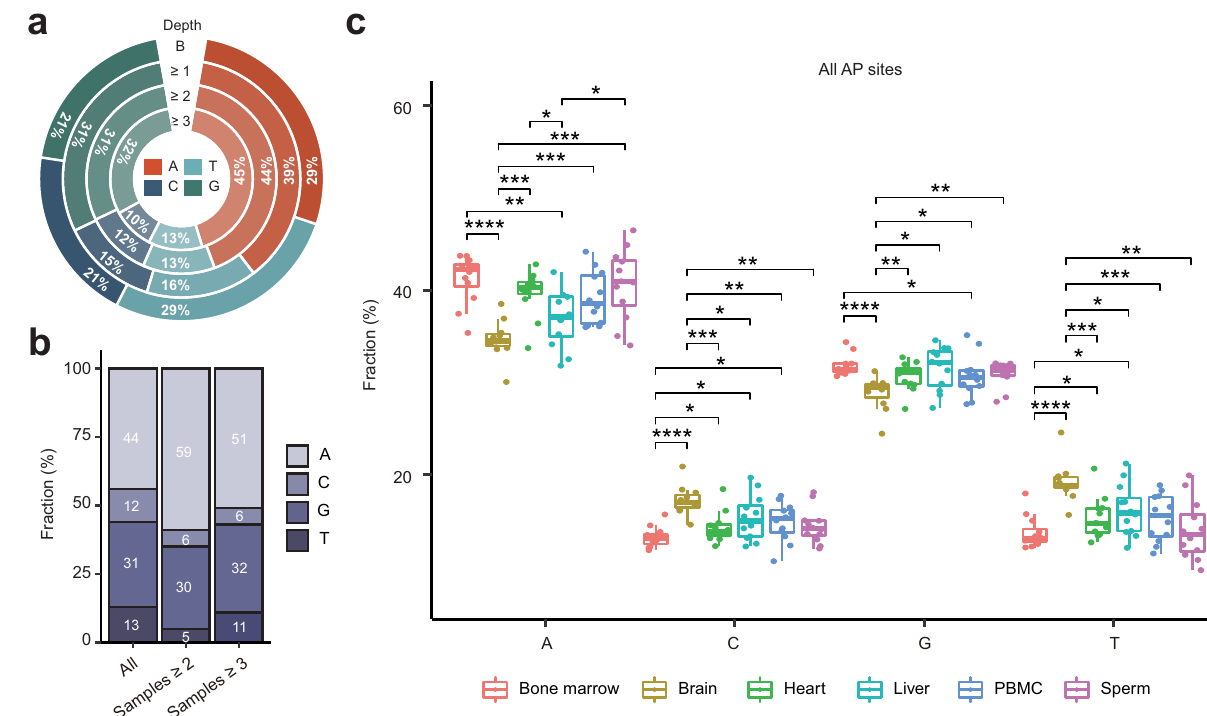
Fig. 7 | Nucleotide distribution of all AP sites in the mouse nuclear genome. a Average fractionsof eachnucleotidein thesequenceof thenonrepeated portion of the mouse nuclear genome ( “ B ” ) as well as in all AP sites ( “ Depth ≥ 1 ” ) or only hotspots ( “ Depth ≥ 2 ” or “ Depth ≥ 3 ” ) across the 71 samples. b Fraction of each nucleotide for all hotspots and those shared by the indicated number of samples. c FractionofeachnucleotideforallAPsitesindifferenttissues(seeSupplementary Fig. 8 for more information). Box plots indicate median (middle line), 25th, 75th